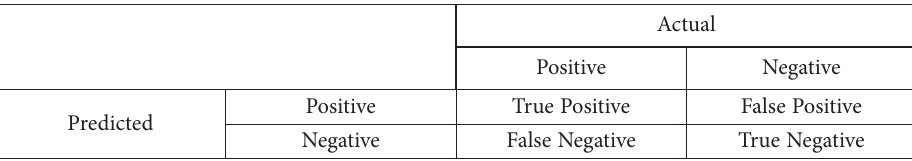
Table 2. Confusion matrix Actual Positive Negative Positive True Positive False Positive Predicted Negative False Negative True